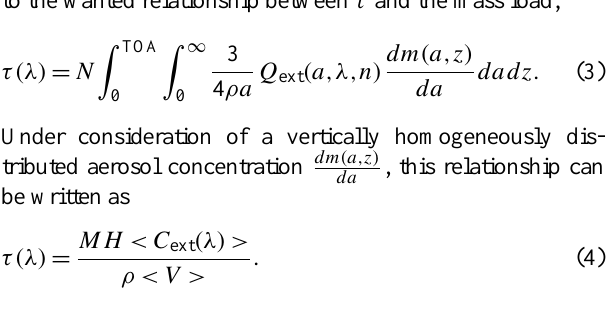
Fig. A6. Filter functions for the conversion between the different definitions of particulate matter mass load. The red curve denotes the weighted distribution function which is a folding of the log- normal distribution with the I SO 7708 weighting function.